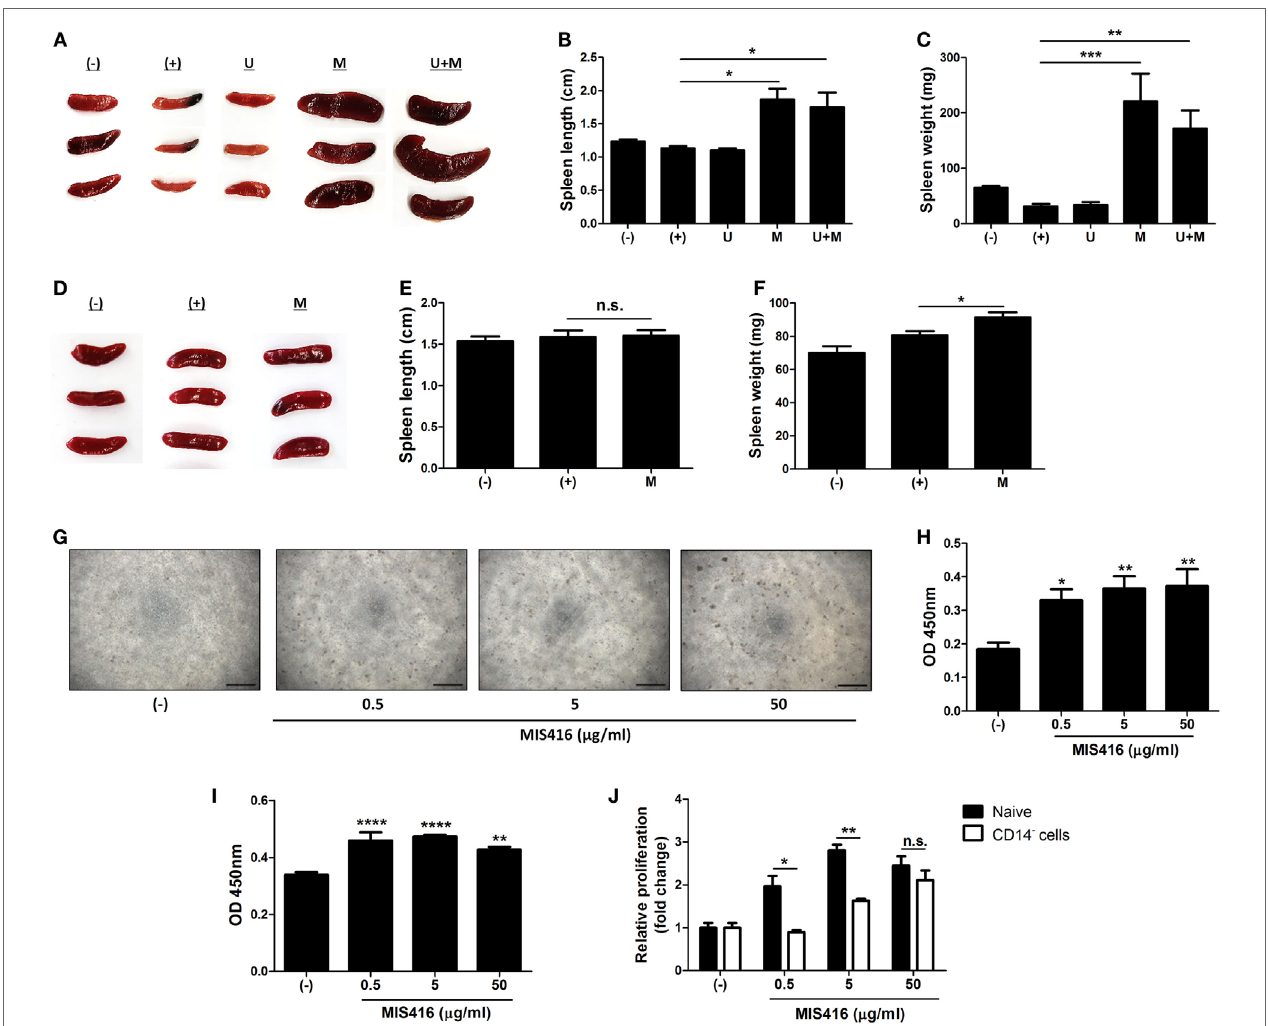
FigUre 4 | Injection of MIS416 alters systemic immune milieu of dextran sulfate sodium (DSS) colitis mice. (a–c) Each group of mice were sacrificed on day 11. (a) Gross examination of spleen. (B) Length and (c) weight of spleens were measured. (D–F) Each group of mice were sacrificed a day after MIS416 administration (day 2). (D) Gross examination of spleen. (e) Length and (F) weight of spleens were measured. (g,h) Human umbilical cord blood-derived mononuclear cells were cultured with MIS416 for 3 days. (g) Representative of bright-field microscopy images of hUCB-MNCs, bar = 100 µm. (h) Proliferation of hUCB-MNCs was determined by bromodeoxyuridine (BrdU) assay. (i,J) hUCB-MNCs or -derived immune cells were treated with indicated concentrations of MIS416 for 3 days. Proliferation of (i) isolated CD14 + macrophage-like cells and relative proliferations of (J) naive and CD14 + cell-depleted hUCB-MNCs and were measured by BrdU ELISA kit. n = 5–9 mice per group, two independent animal experiments were performed. In vitro experiments were performed in triplicate. ( − ): Negative control group, ( + ): DSS administered group, U: hUCB-MSCs treated group, M: MIS416-treated group, U + M: hUCB-MSCs and MIS416 co-treated group. * P < 0.05, **